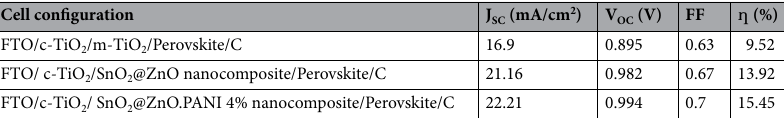
Table 3. Photovoltaic parameters of perovskite solar